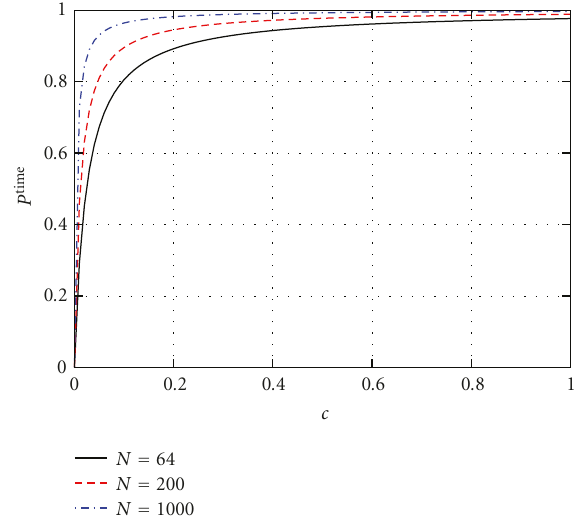
Figure 10: Time penalty, as a function of the fraction of reclustering time c , in a scenario with μ = 1aU. Three possible values of N are considered: (i) 64, (ii) 200, and (iii)